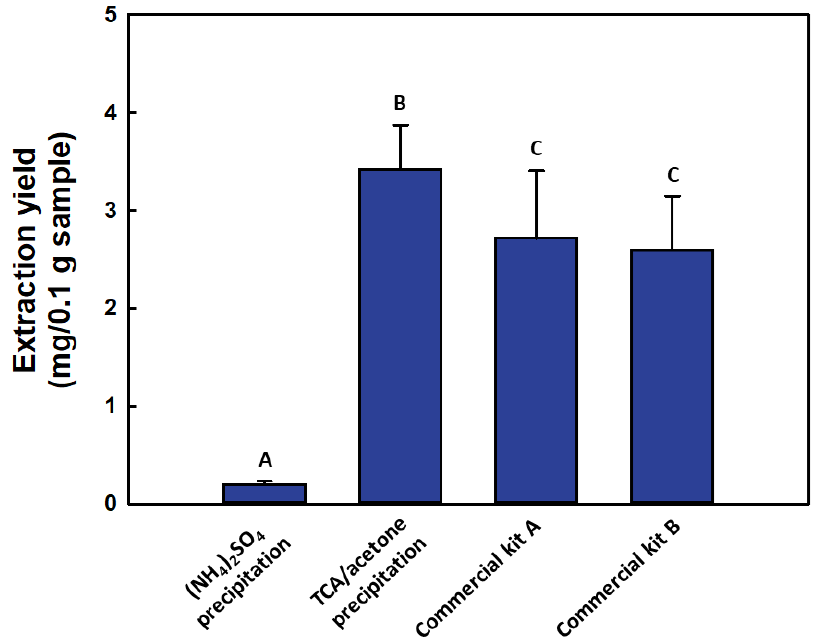
Figure 2. Efficiency comparison of protein extraction yield of universal protein extraction methodologies from 24 Korean domestic agricultural products. Means with different superscripts differ significantly ( p < 0.05).